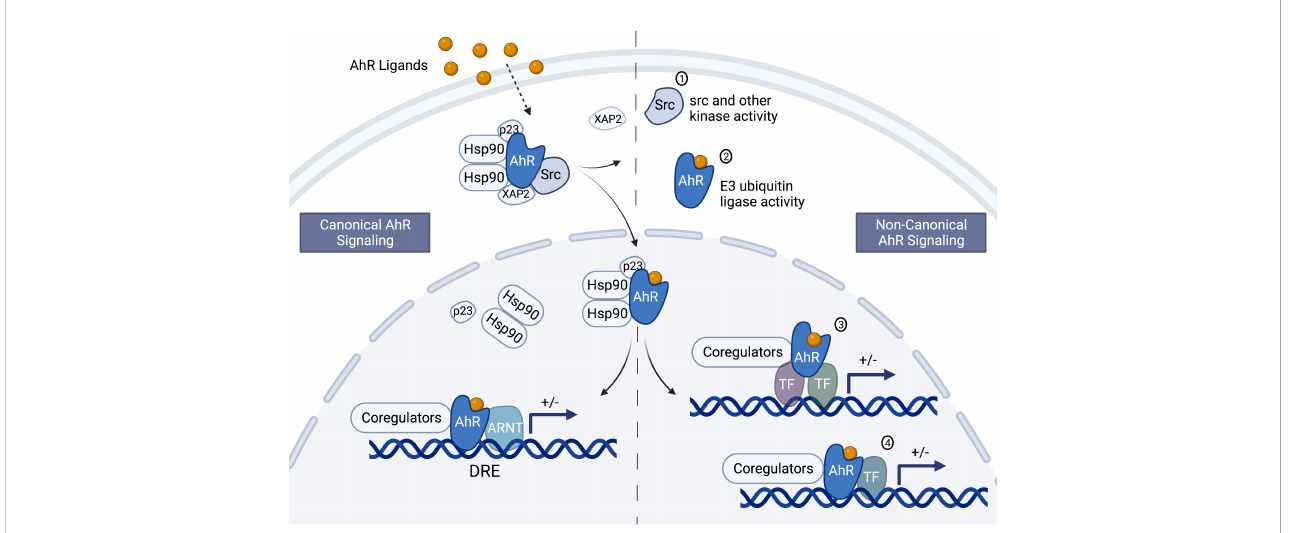
FIGURE 1 Schematic of the canonical and non-canonical aryl hydrocarbon receptor signaling pathways. Depending on the ligand and perhaps other unknown factors, aryl hydrocarbon receptor (AhR) signaling could occur through the canonical and/or the non-canonical pathway. In the cytosol, the AhR is complexed with Src kinase and several chaperone proteins, including the 90 kDa heat shock protein (hsp90), p23 and XAP2 (or AhR-interacting protein, AIP). The chaperone proteins protect the AhR from ubiquitination and keep it in a conformation that can bind ligand. Ligand binding causes a conformational change resulting in the disassociation of XAP2 and Src, exposure of the AhR nuclear localization signal, and AhR translocation into the nucleus. Once in the nucleus the other chaperone proteins dissociate from the AhR leading to canonical or non-canonical signaling. Canonical signaling (left side of the center, dashed line) involves dimerization of the AhR and the AhR nuclear translocator (ARNT) and binding to dioxin response elements in sensitive genes. The AhR/ARNT nuclear complex interacts with coregulators to either positively or negatively (indicated by the “ +/- “ ) modulate gene transcription (bent arrow indicates the transcription start site). Non-canonical signaling (right side of the dashed center line) involves genomic and non- genomic signaling. The non-genomic signaling could be mediated through the release of Src or interactions with other kinases (1) and the E3 ubiquitin ligase activity of the AhR (2). The genomic signaling could be indirect (3) or direct (4) through interactions with transcription factors other than ARNT, such as NF k B/Rel proteins, AP-1, POU, NF-1, SP-1, and KLF-6. Figure was created with